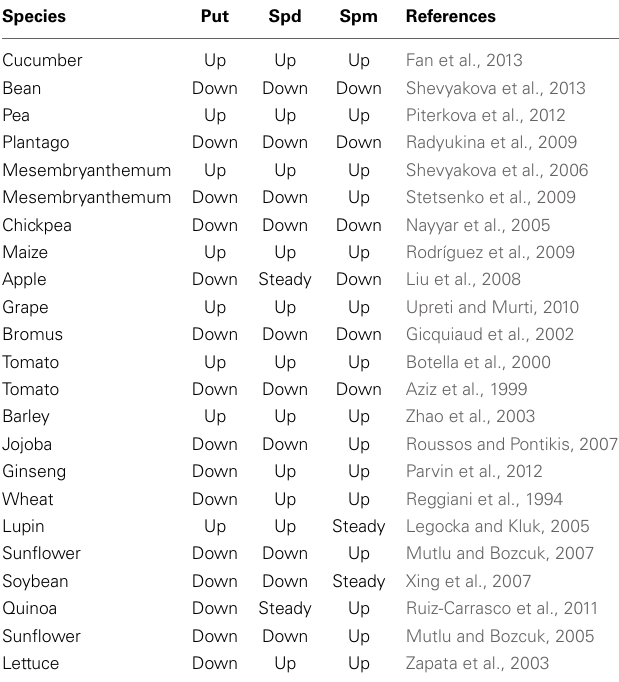
Table 2 | Selected examples of the changes in the level of free polyamines induced by salt stress in plant root and leaf